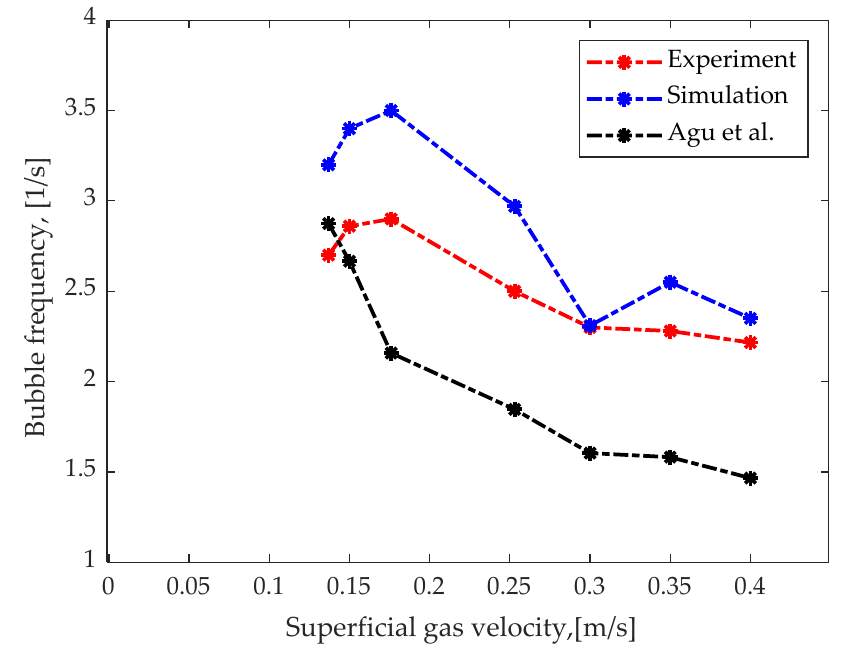
Figure 11. Bubble frequency vs. superficial gas velocities at 15.7 cm bed height [41]. The bubble frequency can be obtained from the fluctuation of the solid volume fraction signal. The solid volume fraction fluctuation for each time step is recorded at different gas velocities. An illustration of the fluctuation of the solid volume fraction at superficial gas velocity of 0.4 m/s is shown in Figure 12a. The bubble frequency is obtained from the Fourier transform of the time series plot of solid volume fraction. The Fourier transform of the solid volume fraction at superficial gas velocity of 0.137 m/s, 0.25 m/s, and 0.4 m/s at 15.7 cm bed height is shown in Figures 12b, 12c and 12d, respectively. The amplitude of the solid volume fluctuation is shown on the Y-axis and frequency on the X-axis. The amplitude gives information about the bubble size. For the bed with a single bubble, the frequency can be obtained, where the amplitude is at the maximum. However, for a bubbling fluidized bed, it is evident that there can be multiple peaks for multiple bubbles passing a plane, as shown in Figure 12c,d. The multiple peaks of the varying amplitude depict that there are multiple bubbles with different sizes passing the plane. With an increase in superficial gas velocity from 0.137 m/s to 0.4 m/s, the amplitude increases. This increase in the amplitude is due to an increase in the bubble size. There is no dominant frequency; however, for each gas velocity, there are several peaks within the band of 1–6 Hz. For gas velocity of 0.137 m/s, the peak of the amplitude fluctuates within a narrow height, which indicates that there are multiple smaller bubbles. At 0.25 m/s, few large bubbles are observed (as indicated by the sudden increase in the amplitude). At superfi- cial gas velocity of 0.4 m/s, the amplitude of the solid volume fraction fluctuation is ap- proximately 60–100 within the band of 2–5 Hz. The higher amplitude with a wide range of bands indicates that the large number of bigger-sized bubbles pass the plane at 15.7 cm.